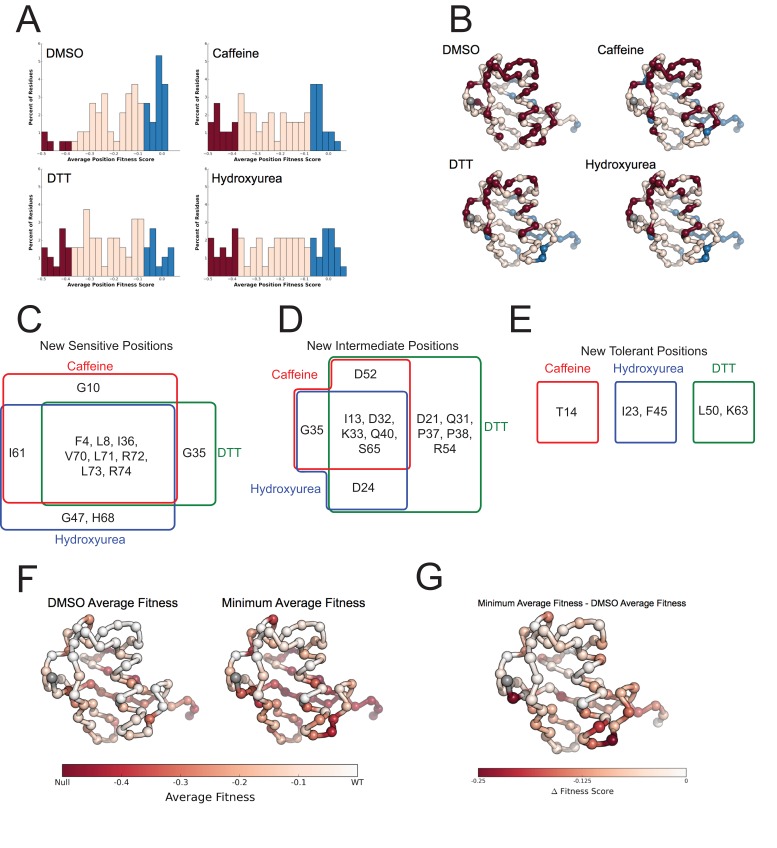
Average fitness values show sensitization by the perturbations at each position in ubiquitin.(A) Based on the average fitness score, positions were binned into tolerant (>=-0.075 - Blue), intermediate (<-0.075 to > -0.35 - Pink) and sensitive (<= -0.35 - Red). (i) DMSO (ii) Caffeine (iii) DTT (iv) Hydroxyurea show a shift from tolerant to intermediate and sensitive positions. (B) Positions binned by average fitness score mapped onto the ubiquitin structure. C-alpha atoms are shown in spheres and the residues are colored as in A. Met1 is colored grey. (C) New sensitive positions induced by the perturbation describe a shared response to perturbation with 8 of 13 positions shared between Caffeine, DTT and HU. (D) New intermediate positions highlight the similarity between HU and Caffeine, with DTT sensitizing a unique set of residues. (E) New tolerant positions are unique to each perturbation. (F) Average position fitness scores mapped onto ubiquitin. (i) DMSO (ii) Minimum average fitness score in all perturbations. C-alpha atoms are shown in spheres and the residues are colored according to average fitness. Met1 is colored grey. (G) Minimum average fitness scores – DMSO average fitness scores mapped onto ubiquitin. C-alpha atoms are shown in spheres and the residues are colored according to the difference in fitness. Met1 is colored grey. With this small set of perturbations most positions are sensitized.